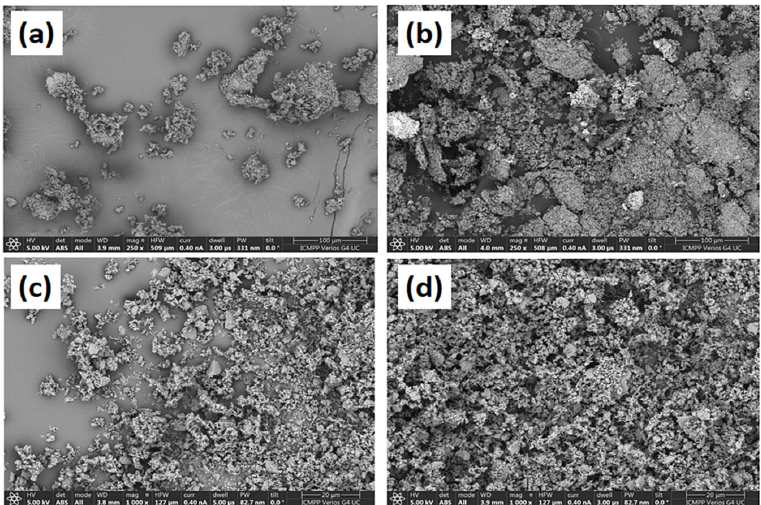
Figure 9. SEM micrographs of the mixtures FeO, different salts (NaCl, Na 2 SO 4 , NaNO 3 , CaCl 2 , MgCl 2 ) ( c s = 1 × 10 − 3 M), kaolin (0.2 g L − 1 ), and FeO and TiO 2 ( w / w , 1/1) in the absence of TMAP 0.7 –P ( a , c ) and their aggregates with TMAP 0.7 –P ( b , d ); dose op : 0.6 mg L − 1 and dose op : 0.2 mg L − 1 ,